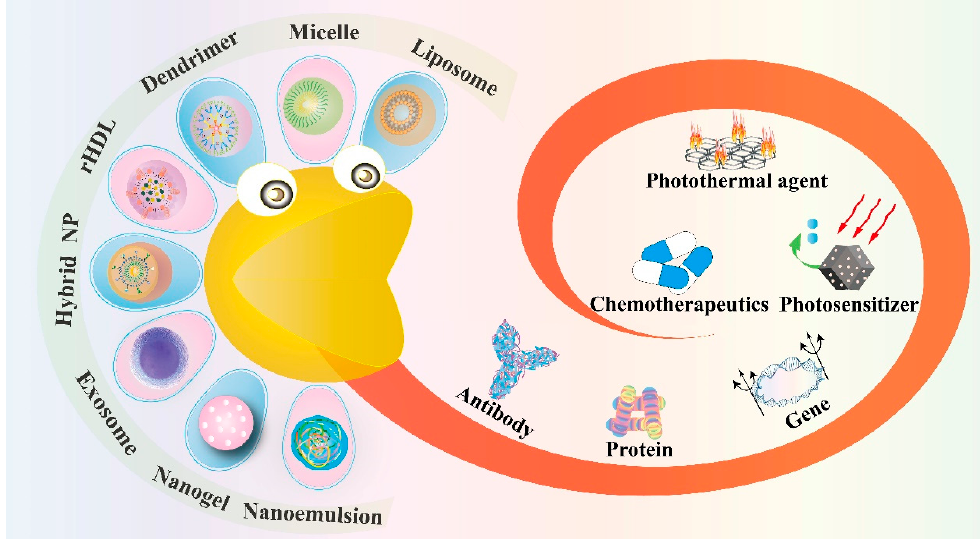
Figure 1. Schematic illustration of novel nano-encapsulation based on various drug delivery vehicles.